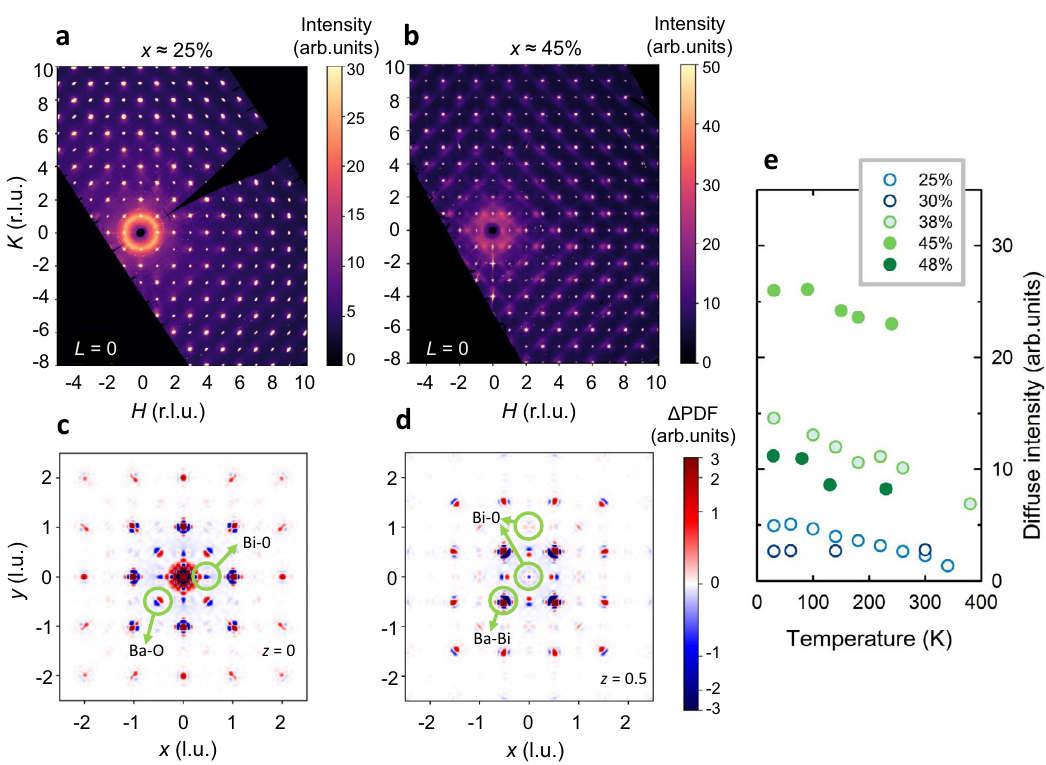
Fig. 2 | Local structure of Ba 1 − x K x BiO 3 . a , b Normalized diffuse x-ray intensity in the L =0planeat30Kfor( a ) x ≈ 0.25,intheinsulatingstate,and( b ) x ≈ 0.45,inthe metallic state; r.l.u. refers to reciprocal lattice units. Structured diffuse scattering that is asymmetric around the Bragg peaks is clearly seen in the metallic sample. c , d Vector pair distribution functions (3D- Δ PDF) obtained for the sample with x ≈ 0.45 (same as in b ), shown in two representative planes ( z =0 in c and z =0.5 in d ),withanumberofBa – O,Ba – Bi,andBi – Ocorrelationpeaksannotated;l.u.refers tolatticeunits.CorrelationsinvolvingKaresuppressedcomparedtoBabecauseof the signi fi cantly smaller x-ray form factor of K. Red and blue indicate higher and lower probabilities of fi nding the respective pair of atoms at a given distance, respectively, compared to the distances that correspond to the average structure. Three main features are clearly seen in the 3D- Δ PDF: dipole-like Ba – O and Ba – Bi